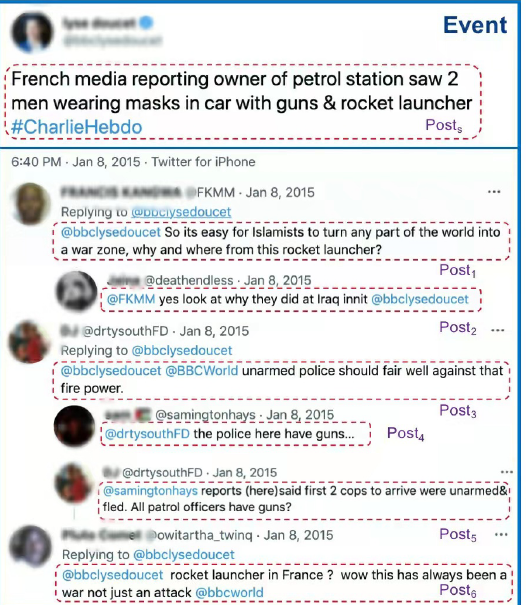
Figure 2. Posts and events on social media (hierarchical structure of the post-level and